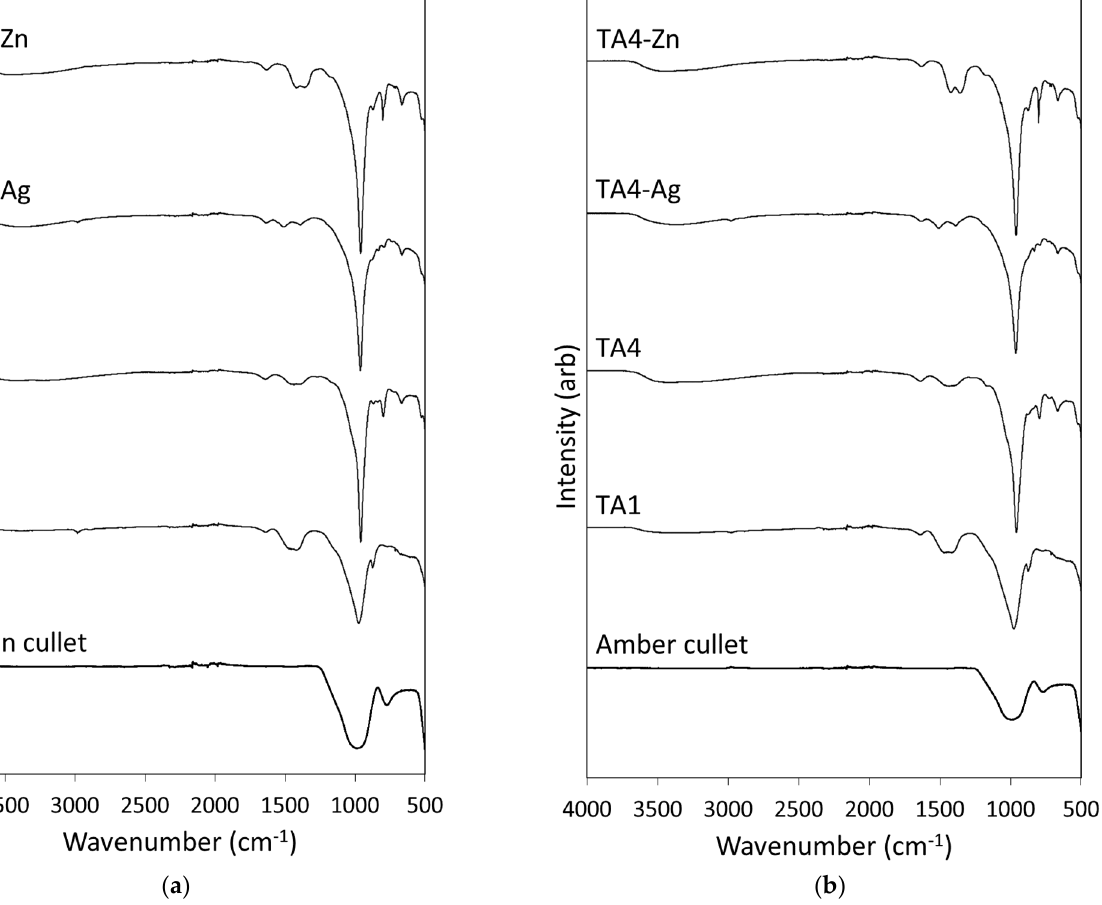
Figure 3. FTIR spectra of ( a ) green cullet and hydrothermal products of green cullet and calcium oxide in 1 M NaOH (aq) (TG1) or 4 M NaOH (aq) (TG4), and Ag + -exchanged TG4 (TG4-Ag) and Zn 2+ - exchanged TG4 (TG4-Zn); and FTIR spectra of ( b ) amber cullet and hydrothermal products of amber cullet and calcium oxide in 1 M NaOH (aq) (TA1) or 4 M NaOH (aq) (TA4), and Ag + -exchanged TA4 (TA4-Ag) and Zn 2+ -exchanged TA4 (TA4-Zn).